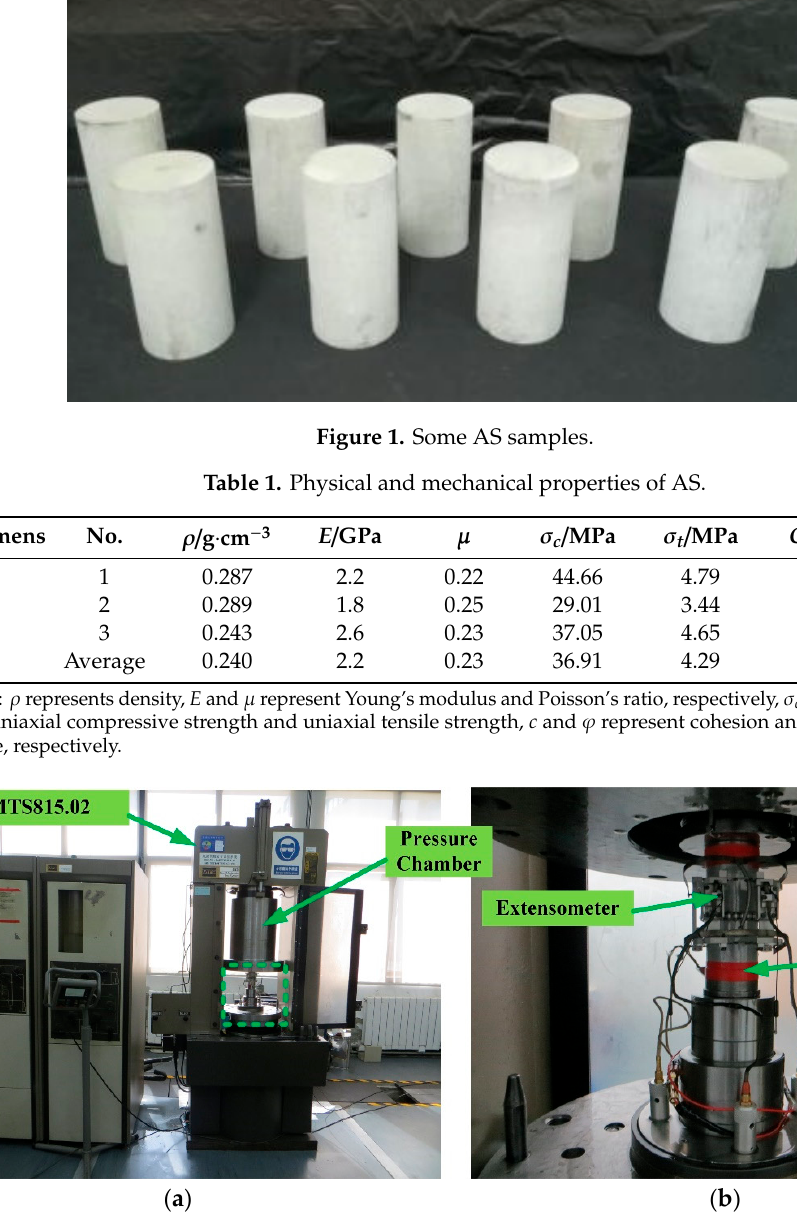
Figure 2. ( a ) Test equipment ( b ) Loading method. Table 1. Physical and mechanical properties of AS.